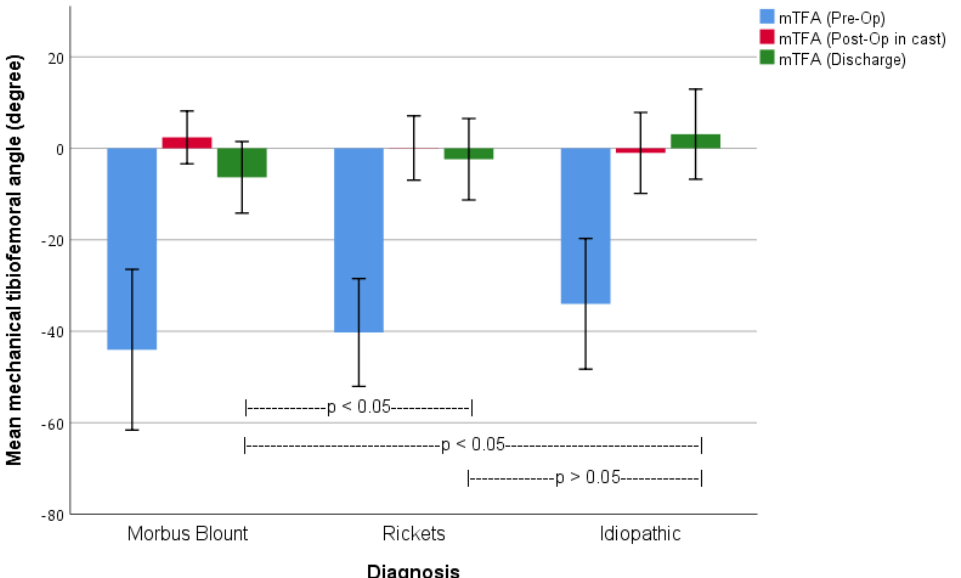
Figure 3. Chronological development of the mean mechanical tibiofemoral angle grouped by etiology of the deformity. Boxes represent the mean value, whiskers show the standard deviation, and p -values show significances between the different etiologies of the mean value of mTFA at dis- charge.